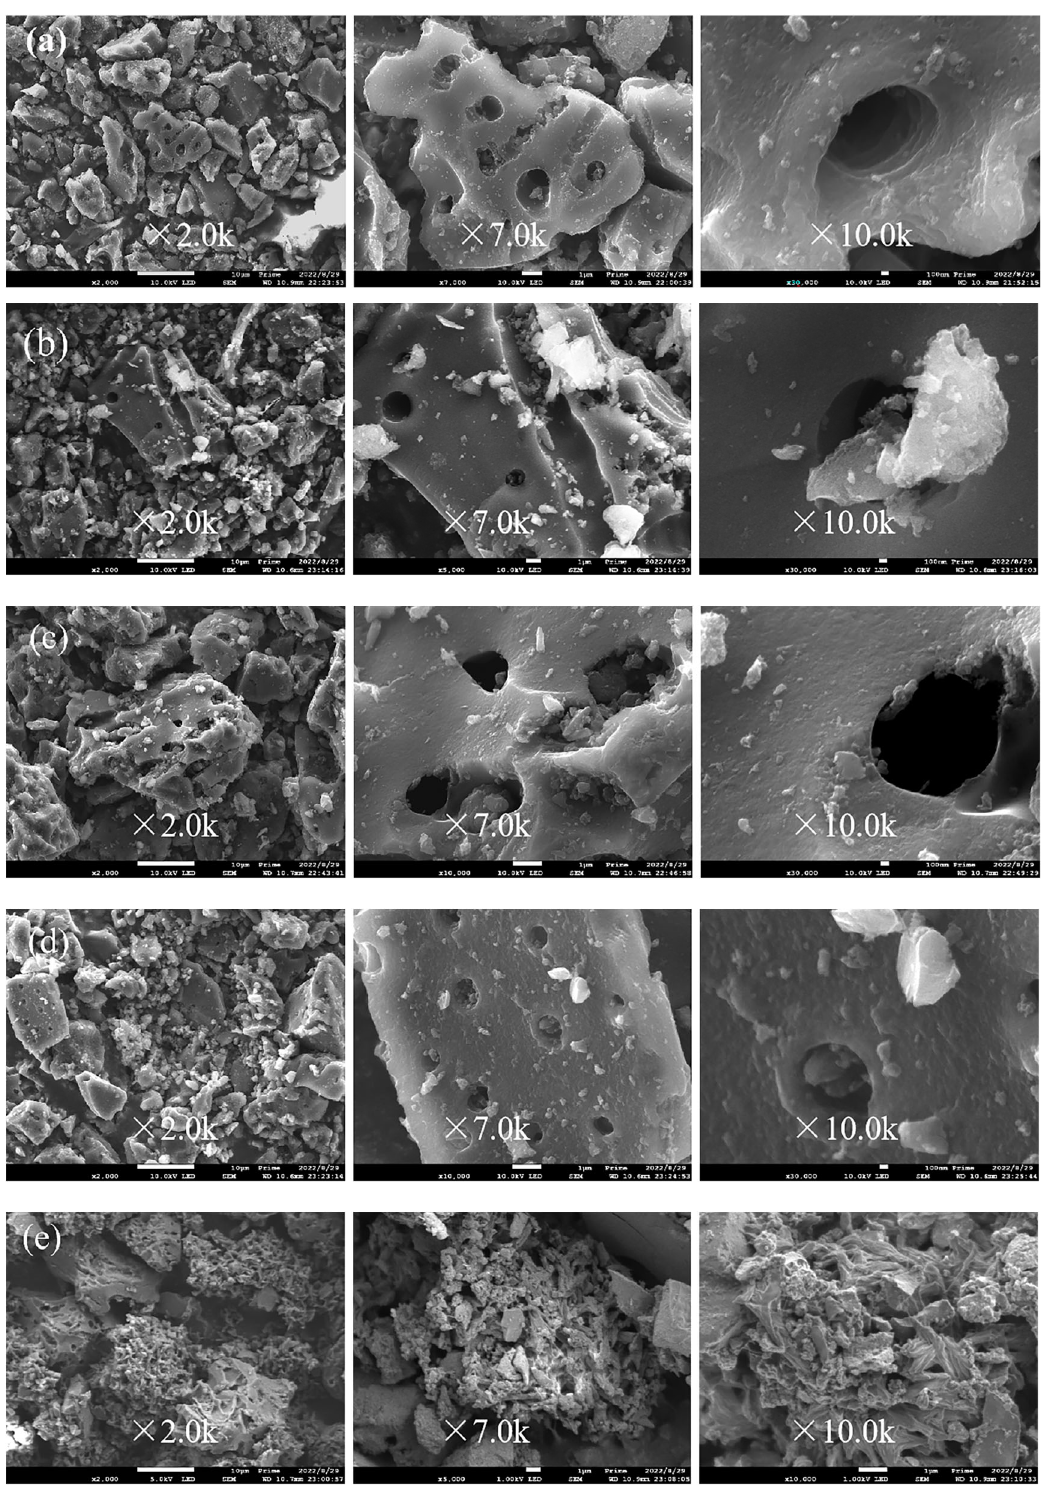
Figure 1. SEM images of SAC: ( a ) SAC (initial); ( b ) SAC ‐ MB (adsorption saturation); ( c ) SAC ‐ MB (regeneration); ( d ) SAC ‐ OFL (adsorption saturation); ( e ) SAC ‐ OFL (regeneration).